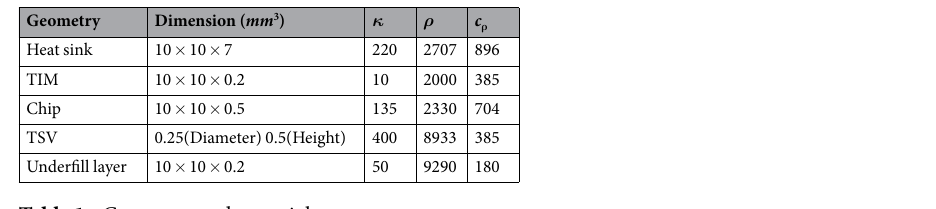
Table 1. Geometry and material